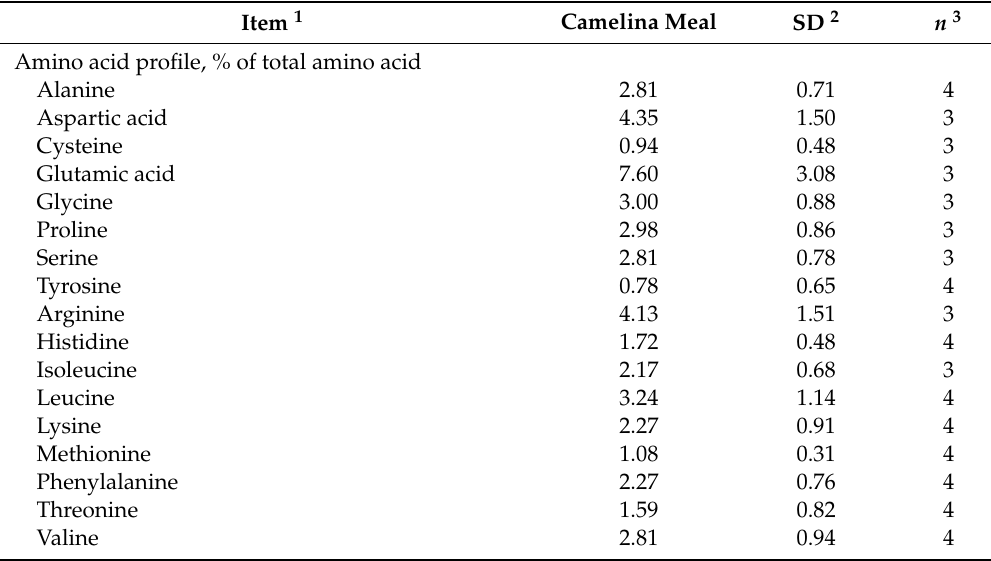
Table 4. Amino acid composition (% of total amino acid) of camelina meal